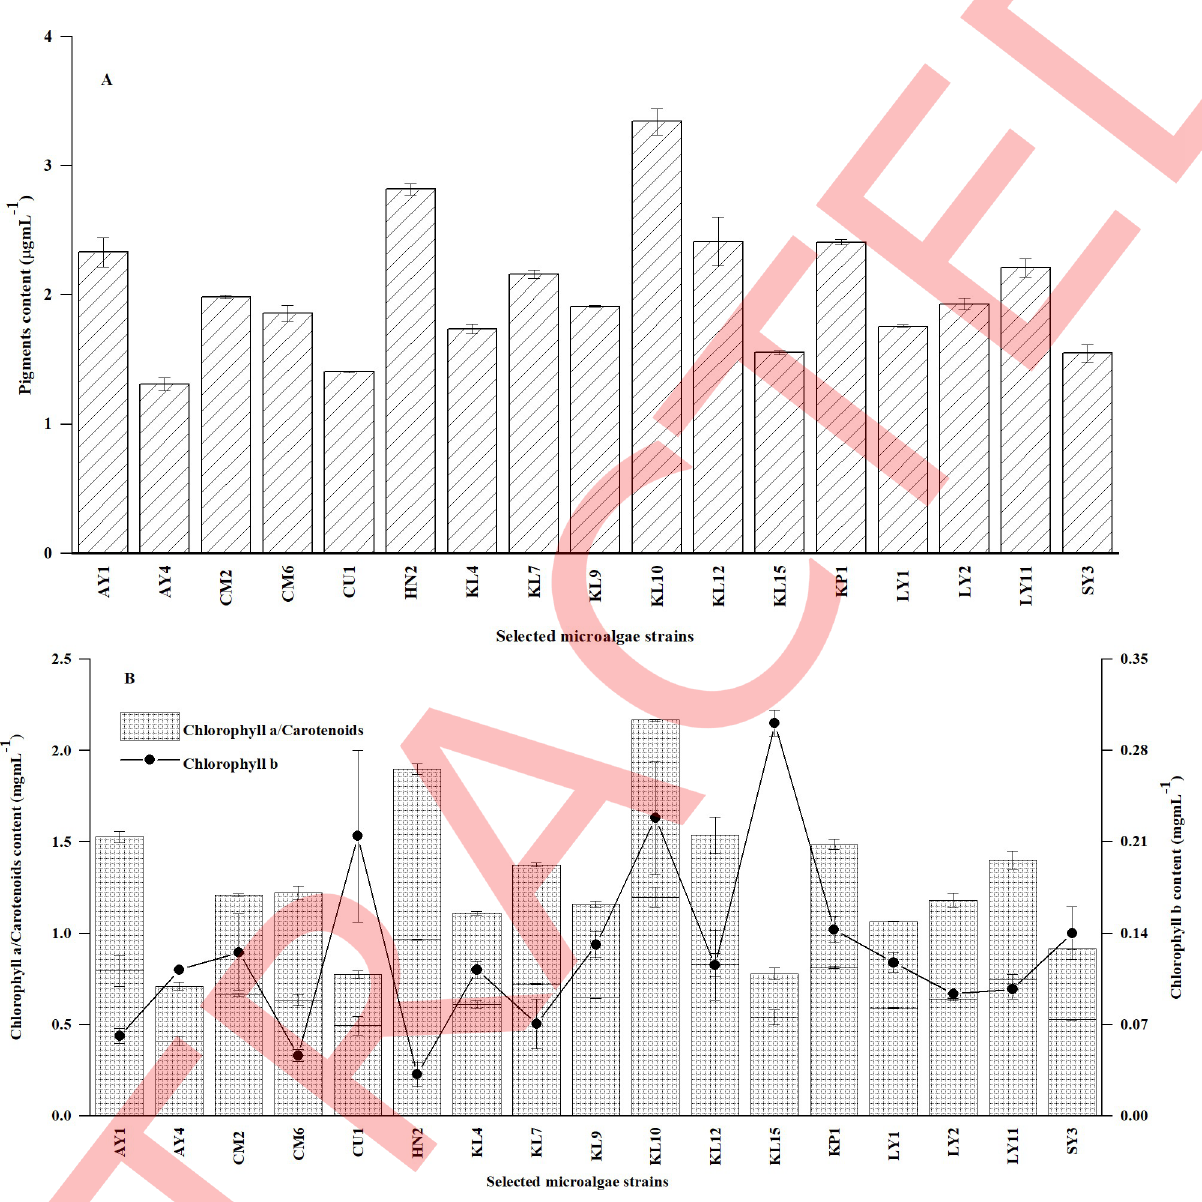
Fig 6. Total pigments’ content (A), and individual pigment content (B) of the selected microalgae strains under mesophilic growth conditions. Error bars indicate standard deviations of the replicate values for each strain. N.B: the term total pigment as used here refers to the sum of the three pigments analyzed in the current